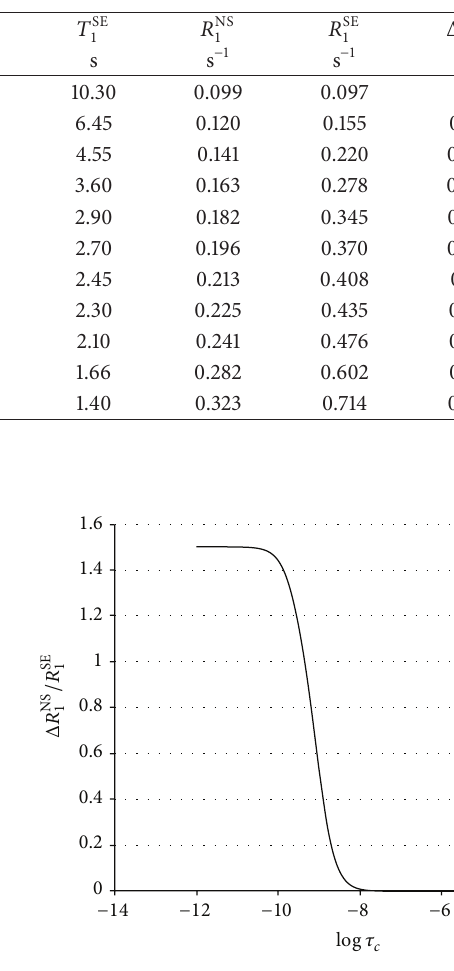
and Δ𝑅 NS is also reported. 1 1